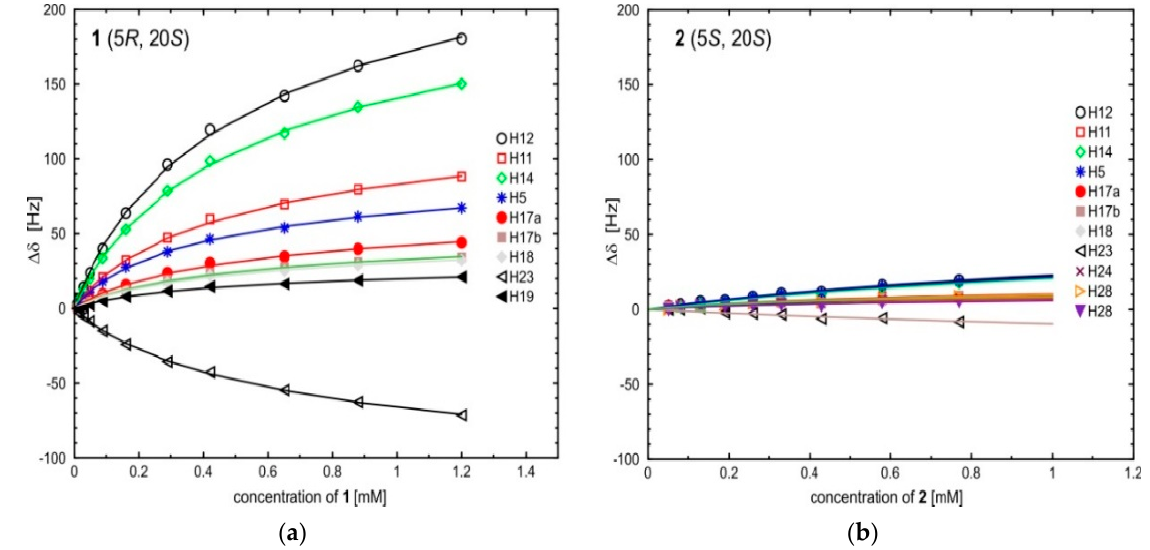
Figure 5. The chemical shift changes Δδ [Hz] of the proton signals of 1 ( a ) and 2 ( b ) as a function of concentration [mM] (D 2 O buffer, 25 mM NaCl/25 mM K 3 PO 4 , TSPA- d 4 , pH 6.4, temp. 10 °C). Positive values correspond to a low frequency shift. Table 2. The diffusion coefficients, Di × 10 − 10 [m 2 s − 1 ] for different concentrations c [mM] for